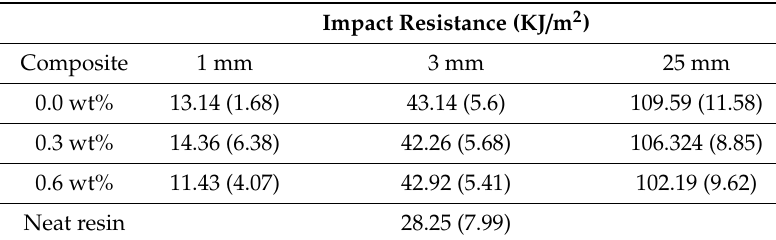
Table 5. The Izod impact resistance of composites and neat resin.